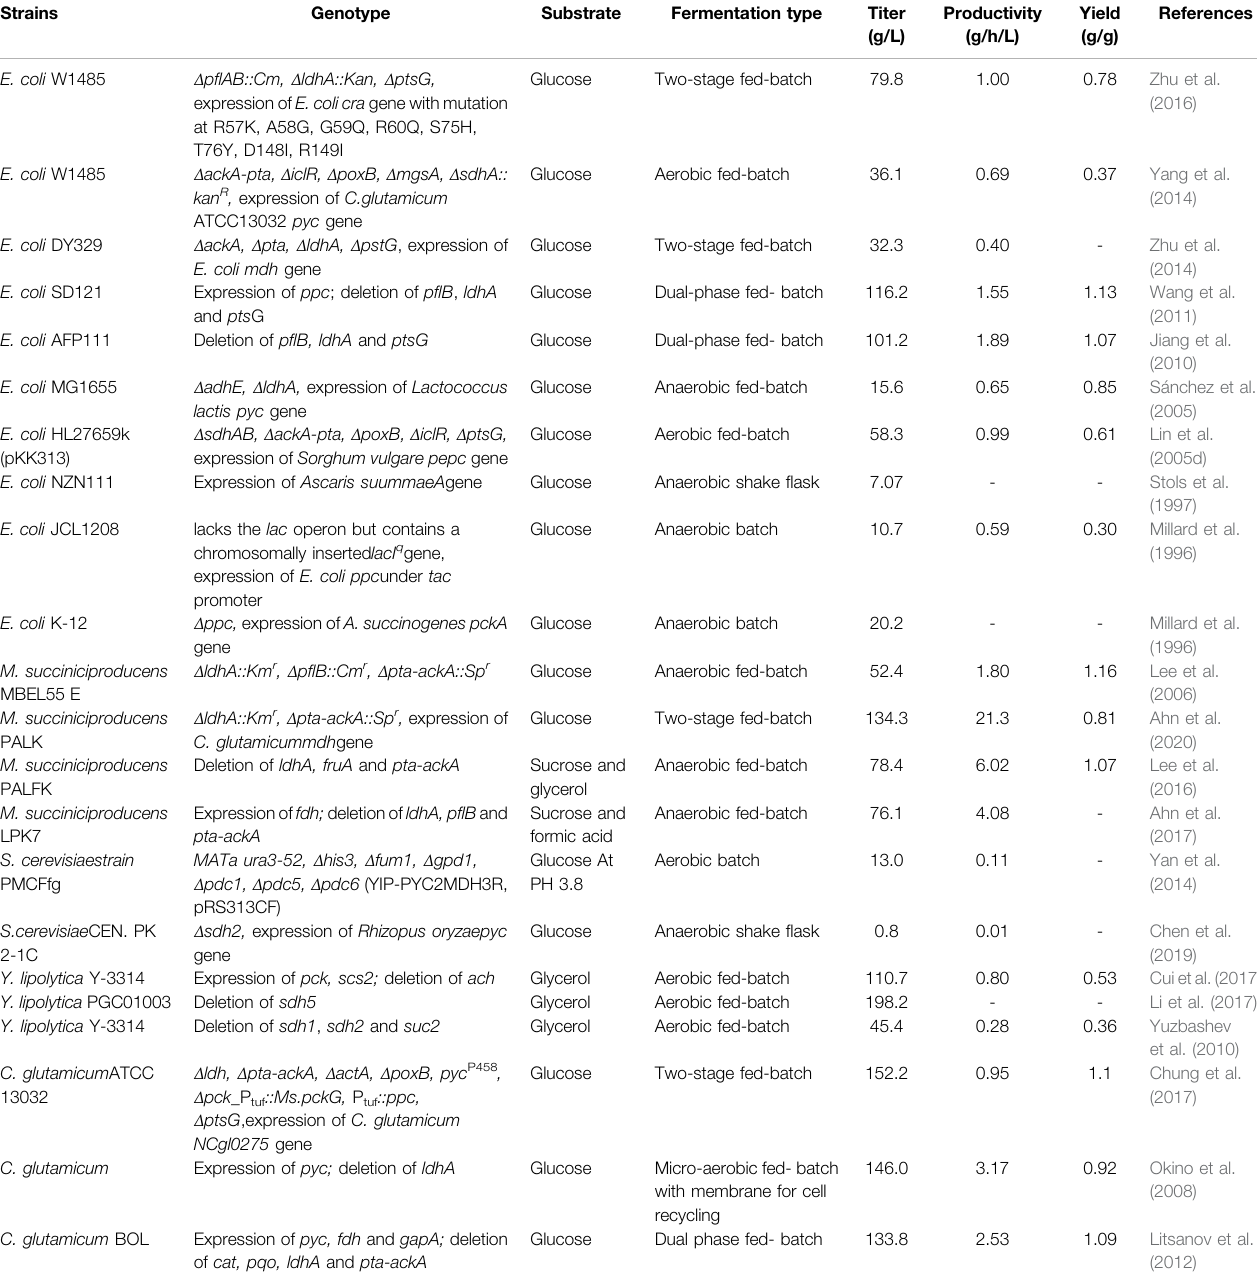
TABLE 3 | Production capacity of succinic acid by metabolic engineering strains in selected papers. Strains Genotype